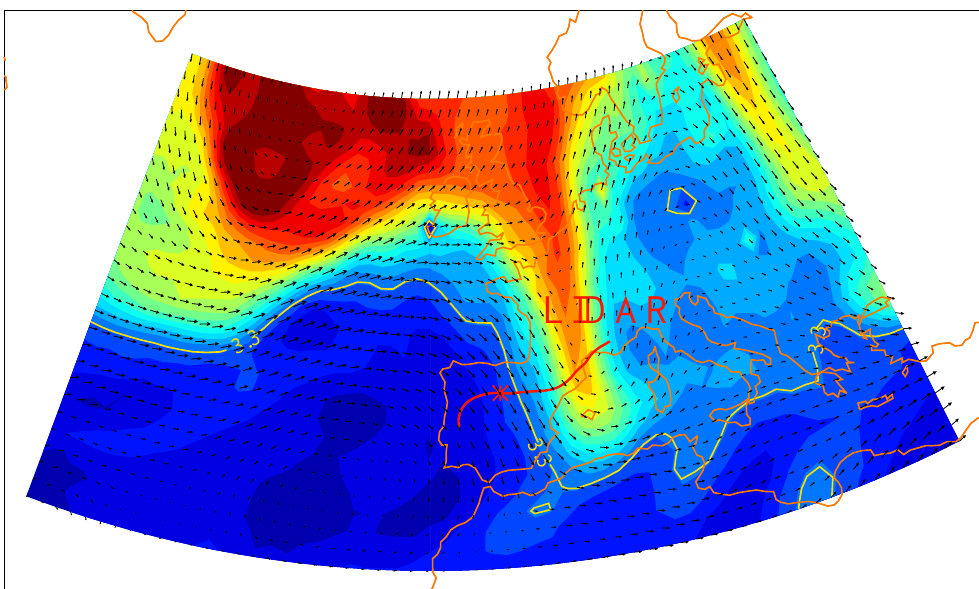
Fig. 5. Horizontal projection of the gravity wave trajectory (red). The starting point of the backward ray-tracing calculations is referred to as “LIDAR”. The contours represents the MPV field on the 340 K isentrope at the time when the observed ray crossed it (2 September 1997 at 14:00 UTC). The star shows the ray intersection with that isentrope. Also shown is the horizontal wind field on the same surface. The indicated MPV contour corresponds to a PV value of 2 PV units (MPV = 3.3 PV unit), that approximately indicates the tropopause. High- (low-) PV values are color-coded in red